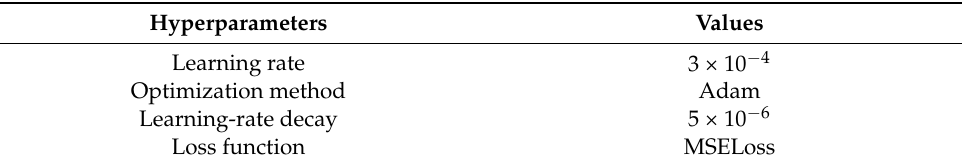
Figure 5. ( a ) Train and validation loss in the training process with and without normalization. ( b ) Average percentage error of each 281 spectrum-point visualizations in the training process. ( c , d ) Prediction performance with and without transposed convolution layers in two extreme situa- tions when the parameters are at the boundaries of sampling space. ( e , f ) Two examples of prediction performance of our FPN model. Table 2. Hyperparameters in model